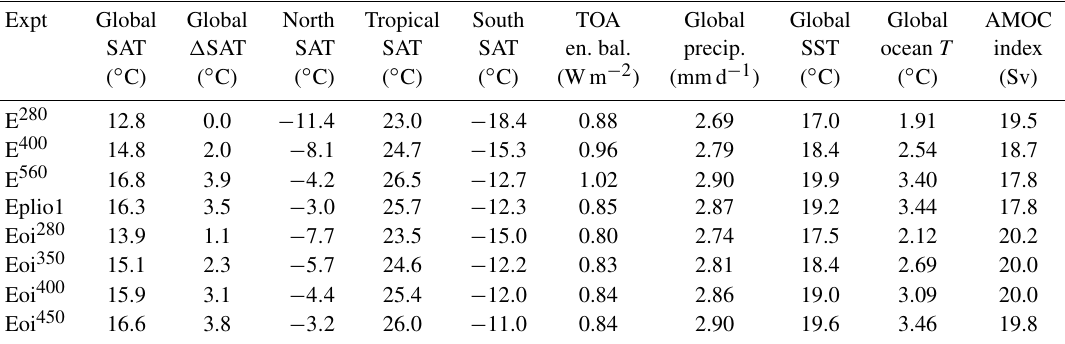
Table 3. Global mean and other values for each experiment, averaged over the last 100 years. From left to right, the columns show the following: (1) experiment name, (2) global surface air temperature, (3) global surface air temperature anomaly with E 280 as the reference, (4) surface air temperature averaged over latitudes 60–90 ◦ N, (5) surface air temperature averaged over latitudes 30 ◦ S–30 ◦ N, (6) surface air temperature averaged over latitudes 90–60 ◦ S, (7) energy balance at the top of the atmosphere, (8) global precipitation, (9) global sea surface temperature, (10) global ocean temperature averaged across all depths, and (11) AMOC index. The AMOC index is averaged over the last 500 years to remove large centennial variability, as seen in Fig. 2.